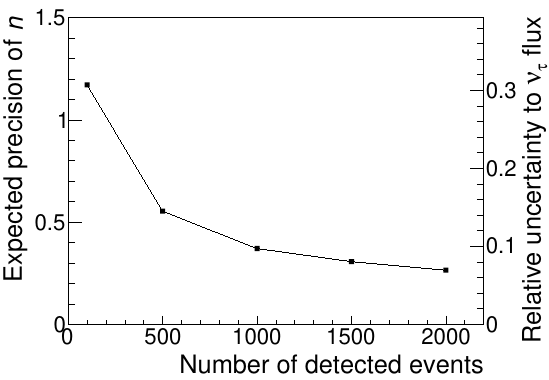
Figure 9 . Expected precision for the measurement of parameter n as a function of the number of detected D s ! (cid:28) ! X events. The estimated relative uncertainty of the (cid:23) (cid:28) (cid:13)ux is also given as the y-axis on the